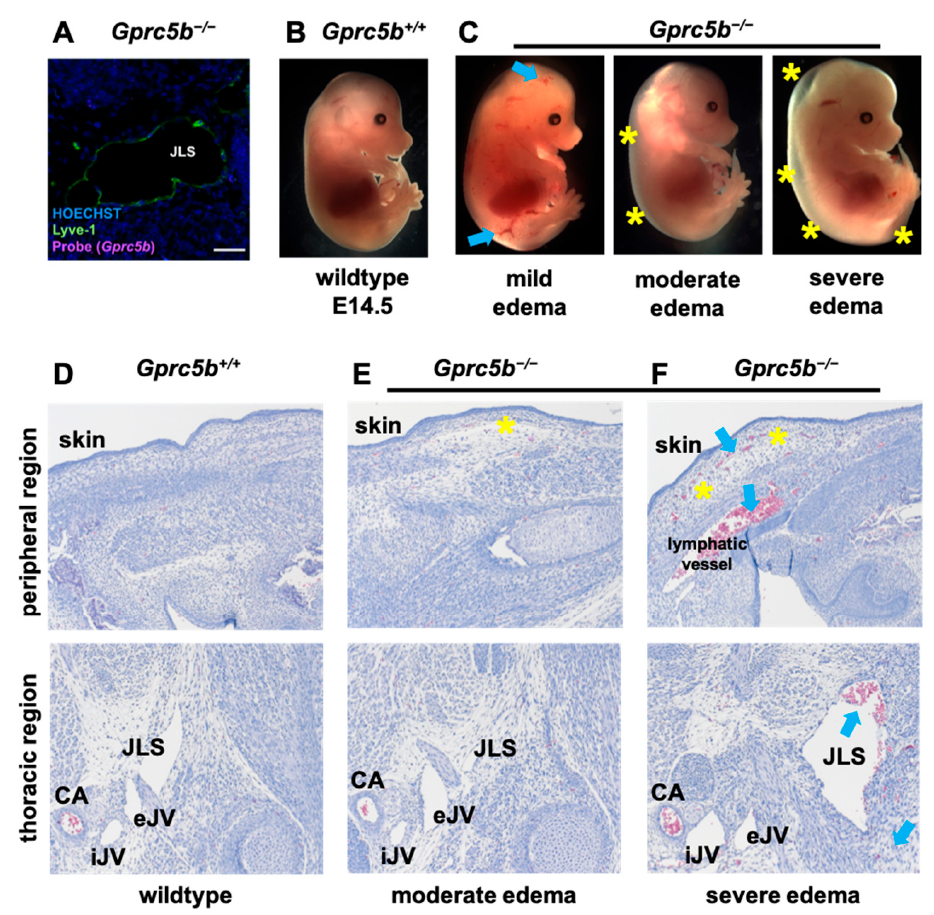
Figure 3. Lymphatic development is attenuated in murine Gprc5b − / − embryos. ( A ) RNAscope per- formed on jugular section of Gprc5b − / − embryo, confirming absence of mRNA expression (compare to Figure 1F): Gprc5b probe (magenta), LYVE-1 lymphatic marker (green), Hoechst cell nuclei (blue). ( B ) E14.5 Gprc5b +/+ littermate control embryo. ( C ) E14.5 Gprc5b − / − embryos show graded levels of edema (yellow asterisks) and hemorrhagic plaques (blue arrows). Compared to normal Gprc5b +/+ littermate controls ( D ), representative H&E images showing subcutaneous edema in the back skin (upper panels, yellow asterisks) and blood-filled lymphatic vessels (lower panels, blue arrows) in Gprc5b − / − embryos with moderate to severe edema ( E , F ). CA, carotid artery; iJV, internal jugular vein; eJV, external jugular vein, JLS, jugular lymph sac.